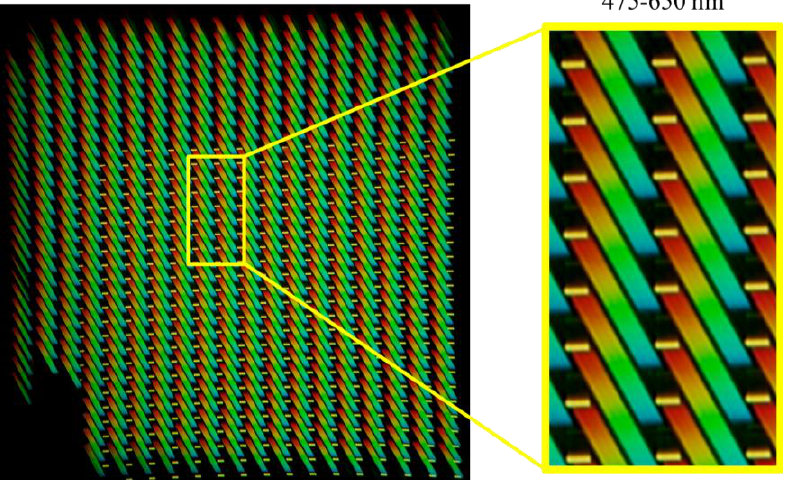
Figure 7. White light spectra on the detector with the whole system and uniform illumination.